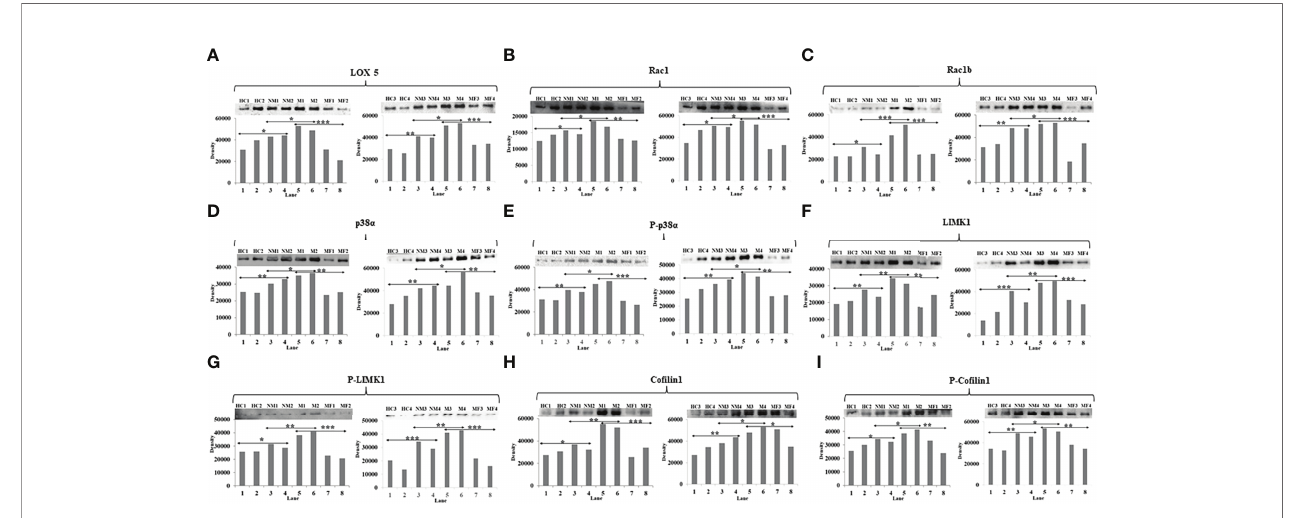
FIGURE 5 | Western blot image and their densitometry analysis of proteins (A) LOX5, (B) Rac1, (C) Rac1b, (D) p38 a , (E) phospho-p38 a (Y-182), (F) LIMK1, (G) phospho-LIMK1 (T-508), (H) Co fi lin1, (I) phospho-Co fi lin1 (S-3) between HC, NM, M, and MF (Lanes-1&2-HC, 3&4-NM, 5&6-M, and 7&8-MF). An unpaired t-test was used to compare the means between two groups (**p<0.01 and